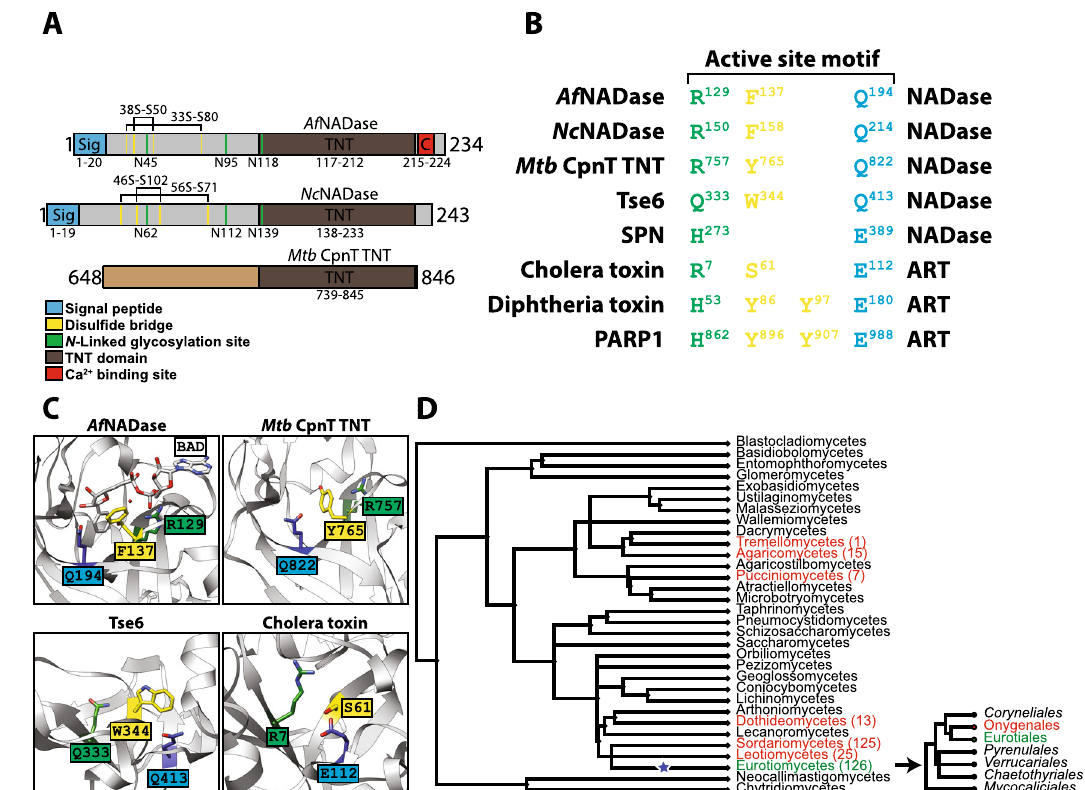
Fig. 5 Af NADase is the founding member of a family of fungal NADases. A Domain architecture of Af NADase, Nc NADase and Mtb CpnT TNT. B Structure-based alignment of active site motifs of NADases and ADP-ribosyltransferases. The residues are found in three distinct regions and are coloured according to their location in the sequence. C Comparison of the active sites of Af NADase in complex with BAD, Mtb CpnT TNT, Tse6 and cholera toxin. Amino acids are coloured based on their position in the active site motif, as in ( B ). D Phylogenetic distribution of NADase within the kingdom fungi. Classes with the NADase are coloured red or green, red for classes without the calcium binding site and green for those with the calcium binding site, and the number in parentheses represents the number of species within the class that harbour the NADase. The calcium binding site emerged (blue star) in the Eurotiomycetes, and is only present in the order Eurotiales